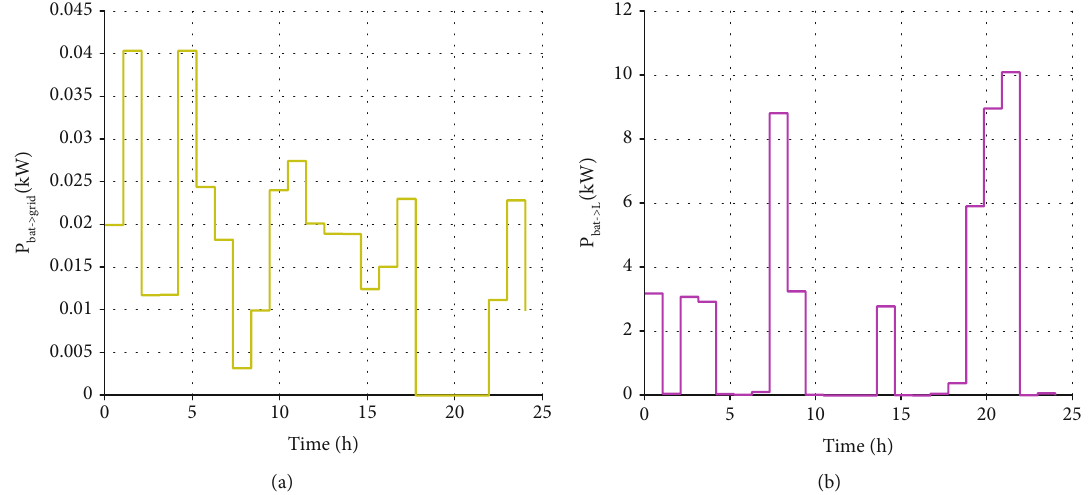
Figure 20: (a, b) Discharged power from the battery to the grid and load by FMINCON, respectively.